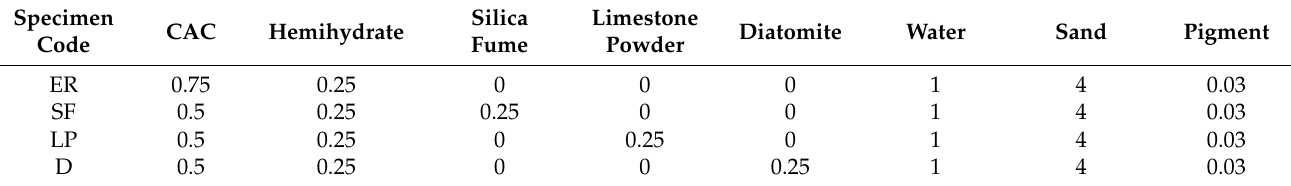
Table 2. Mix proportion of ettringite-rich systems by mass ratio.